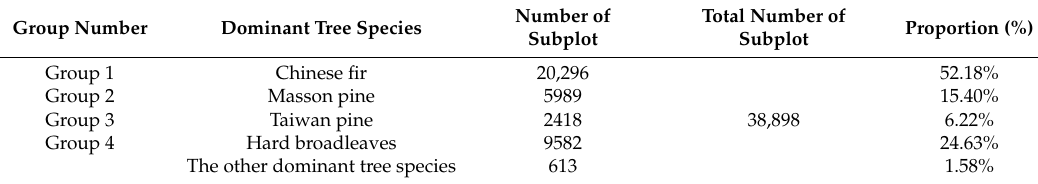
Table 2. Groups divided by the dominant tree species and the size of